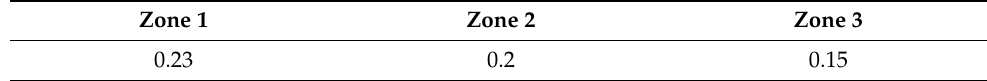
Table 6. Comparison of tunnel crash rate in different zones.